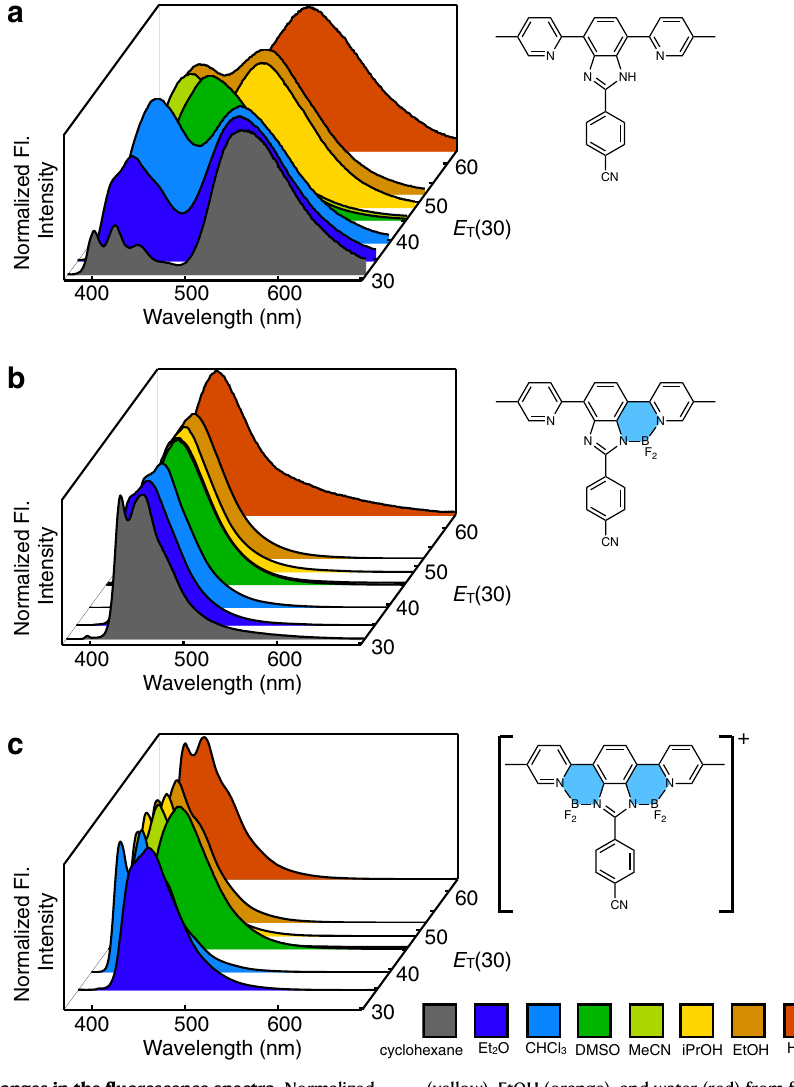
(yellow), EtOH (orange), and water (red) from front to back corresponding to increasingsolventpolarityasdenotedbythe E T (30)values 19 inthe y -axis( T =293K; λ exc =350nm). DMSO dimethyl sulfoxide, i Pr